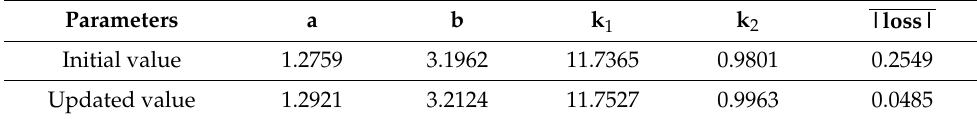
Table 6. The comparison of the Ottosen parameters and the loss values.